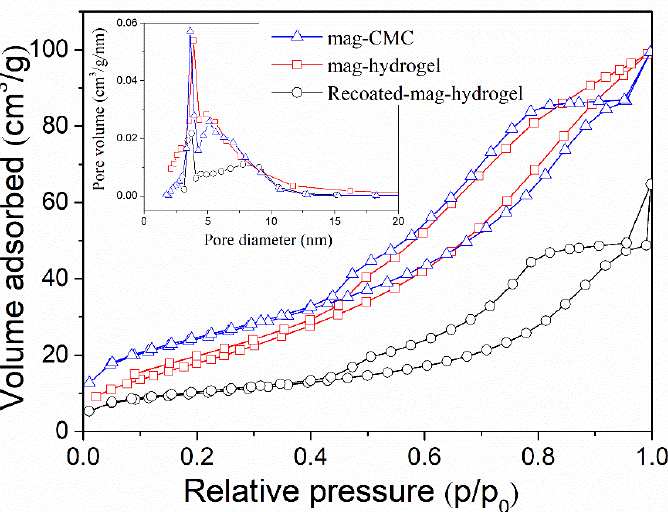
Figure 5. N 2 adsorption-desorption isotherm and pore size distribution curves of magnetic nanocomposites.